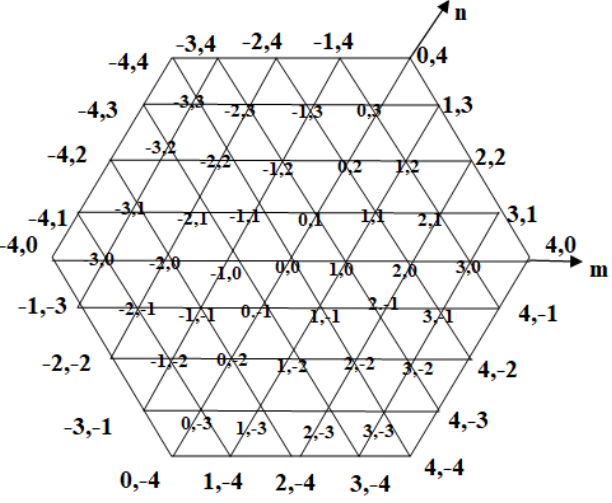
Figure 44. Sixty-degree coordination system for five-level inverter.